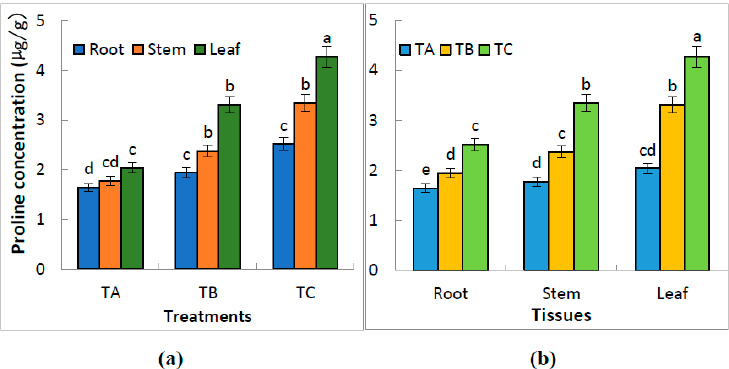
Figure 3. Effect of three water treatments (TA, well-watered (85% PC); TB, moderate water stress (65% PC); and TC, severe water stress (45% PC)) on the proline concentration (fresh weight basis) of leaves, stems and roots of lucerne seedlings by treatment ( a ) and the comparison of the effects of the three water treatments in the tissues ( b ). The bars are ± one standard error of the mean ( n = 3). Means with different lower-case letters are significantly different at P = 0.05 according to Tukey’s multiple range